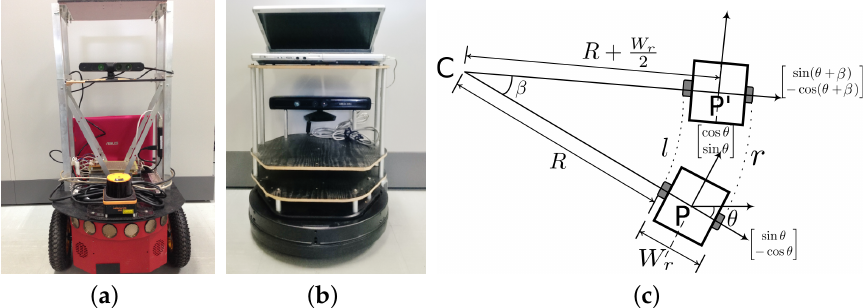
Figure 7. Robots used in the experiments. ( a ) Pioneer P3DX; ( b ) Kobuki Turtlebot; ( c ) Motion model of two wheel differential drive robots.